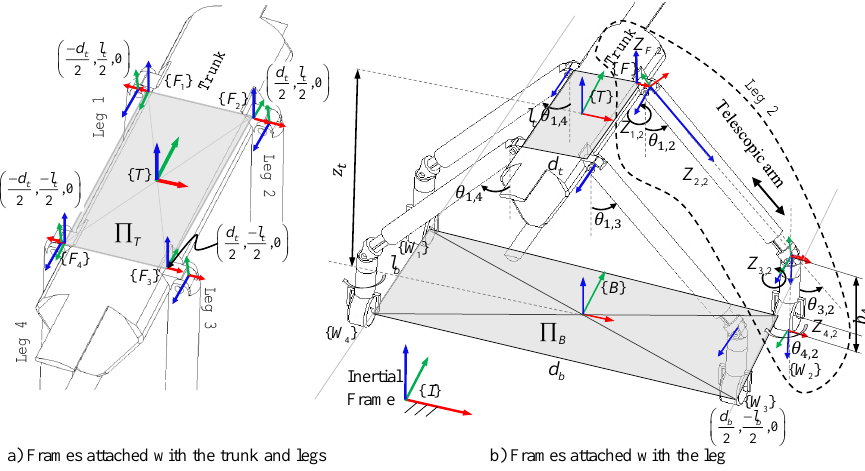
Figure 8. The inertial frame {I}, body fixed frame {T} at the trunk, base frame {B} at the center of the contact point of four wheels with the ground and the DH frames attached with leg 2 having RPRR